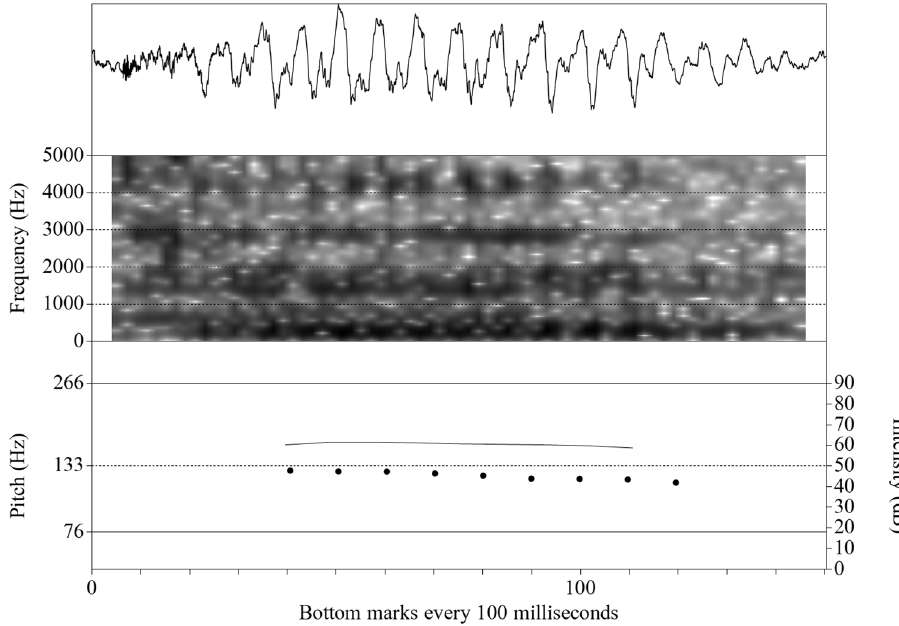
Figure 5: Waveform ( upper panel ) , spectrogram ( middle ) , and F0/intensity trace of L ’ s “ mm ” ( Example 2 line 15 ) . F0 trace scaled to L ’ s minimum/maximum F0, median marked at 133